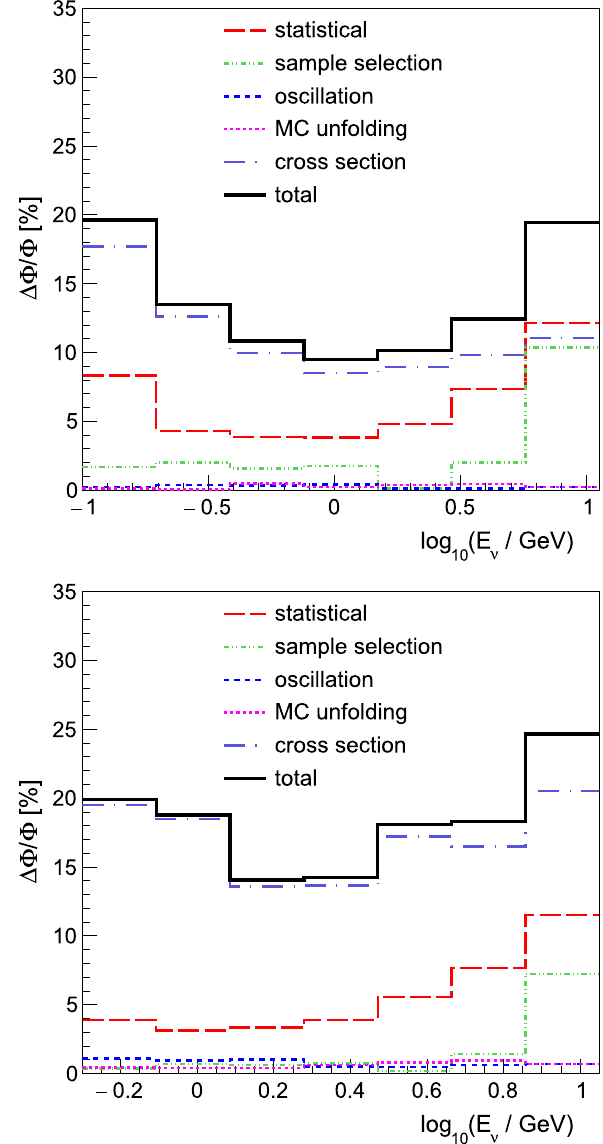
Fig. 8 Summaryofestimatedrelativeuncertaintyontheunfoldedflux, reported separately for each source. The total relative uncertainty is also reported. Top: ν e spectrum; bottom: ν μ